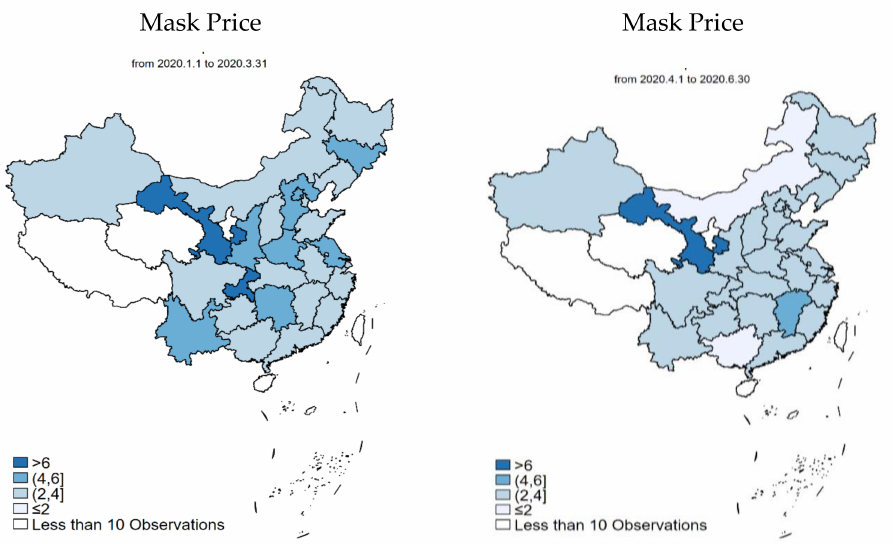
Figure 3. Average price of face masks during Period 1 and Period 2 in China at the provincial